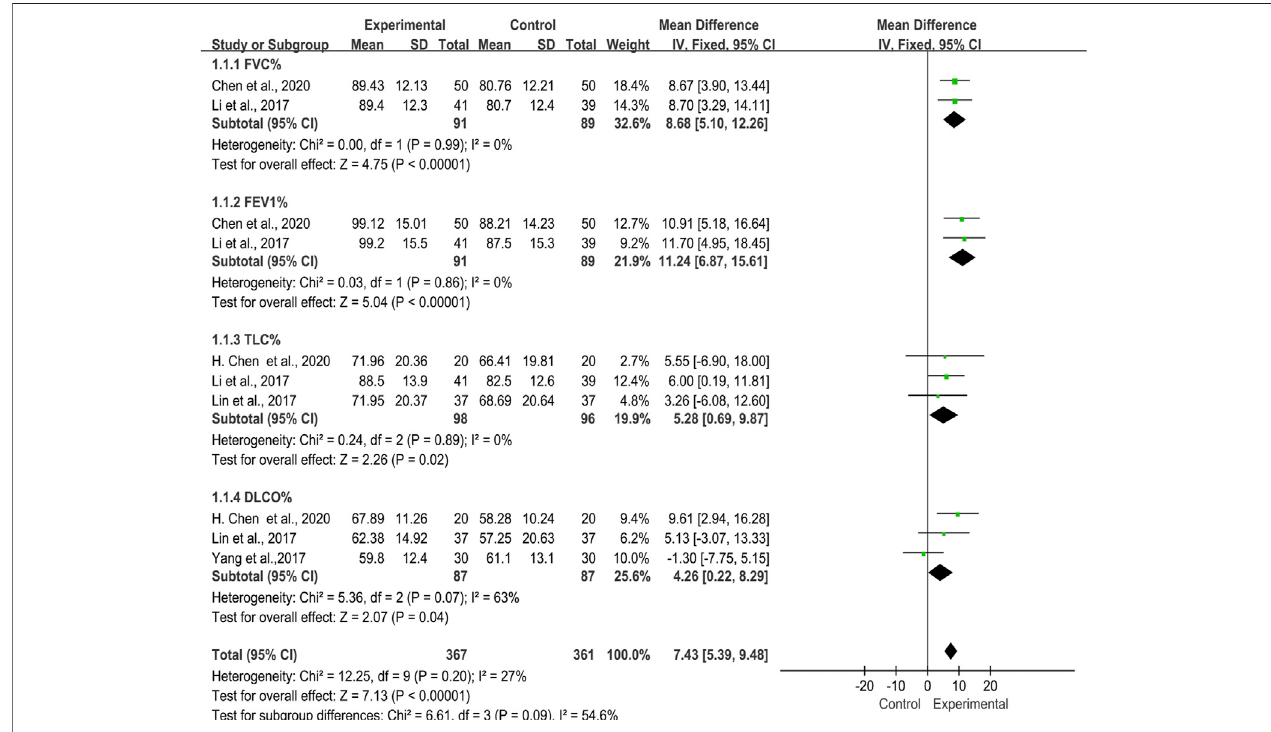
FIGURE 3 | Forest plot of improvement of lung function with TwHF combined with conventional treatment versus pure conventional treatment.